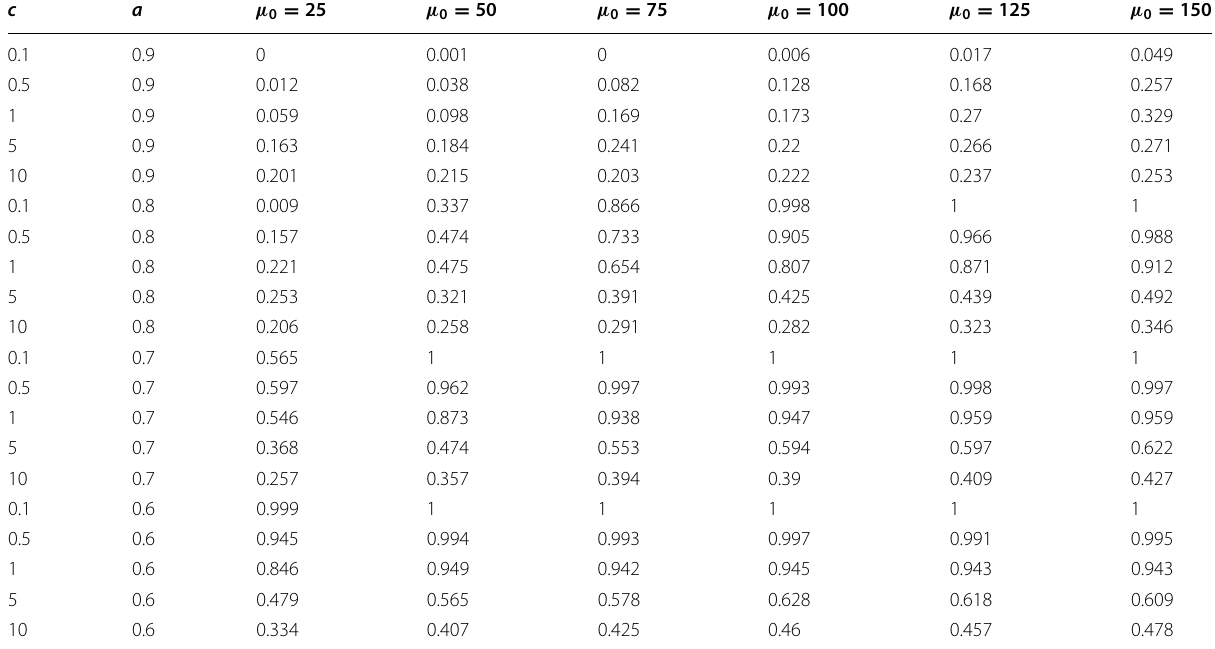
Table 1 PROB of the CPCAT (decreasing trend)